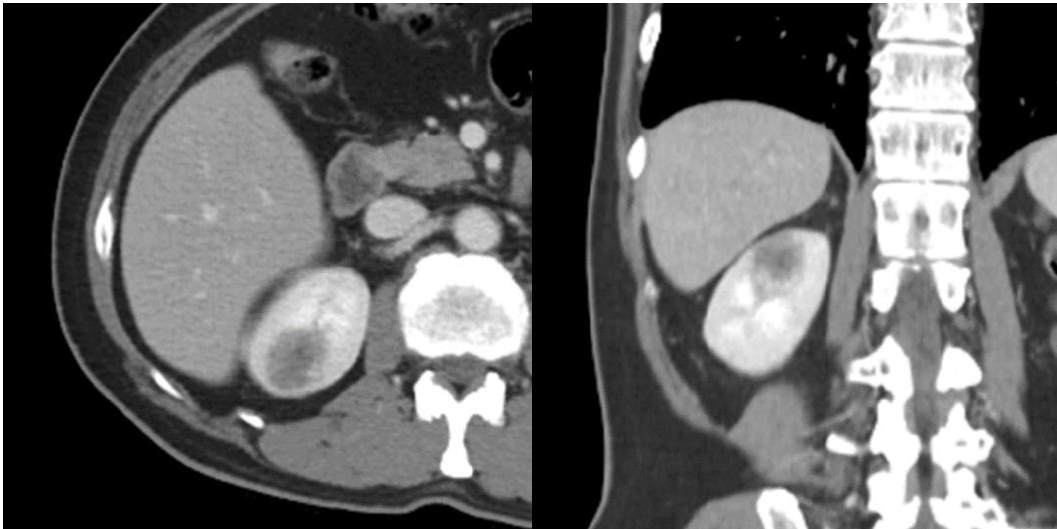
Figure 4. Eighteen months later, multiple small hypodense lesions in the left subphrenic space and along the lateral portion of the left retroperitoneal space (arrows) were noted on an abdominal CT scan.